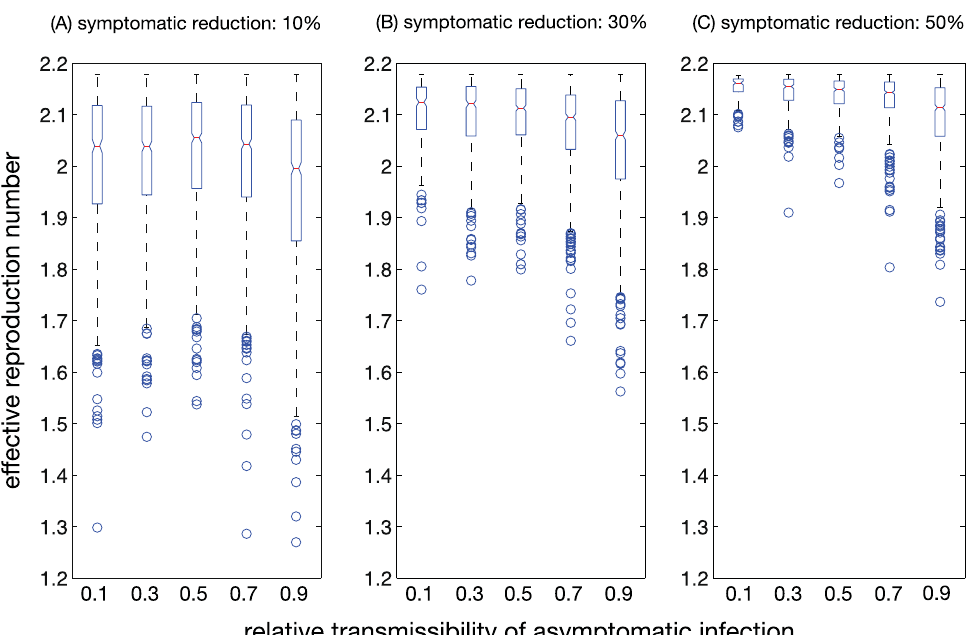
Figure 3. Effective reproduction number at the end of the first wave as a function of the relative transmissibility of asymptomatic infection. The contribution of symptomatic ZIKV infection to disease transmission through mosquitoes was reduced by 10% ( A ), 30% ( B ), and 50% ( C